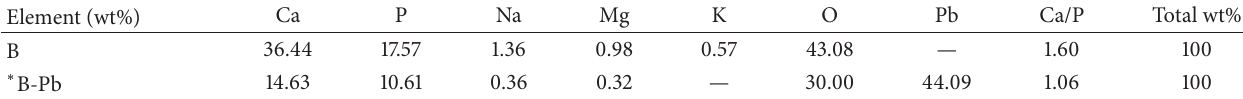
Table 2: Element compositions and Ca/P mole ratios of fish bones by SEM-EDX.